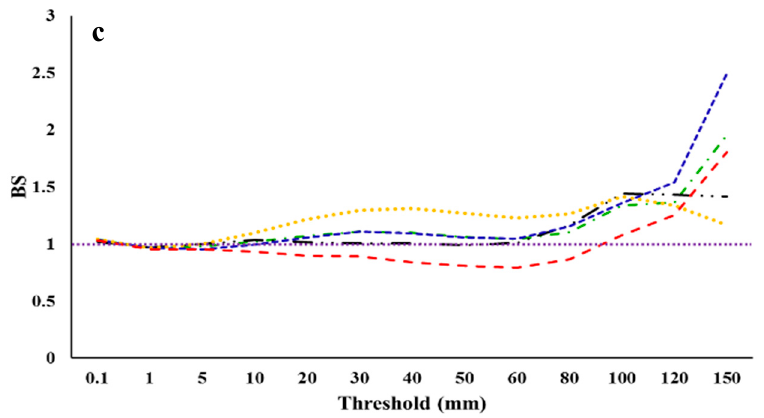
Figure 9. The 24 h accumulated rainfall forecasting scores as a function of forecast leading time for the ( a ) Fraction Skill Score (FSS), ( b ) Equitable Threat Score (ETS), and ( c ) Bias Score (BS).